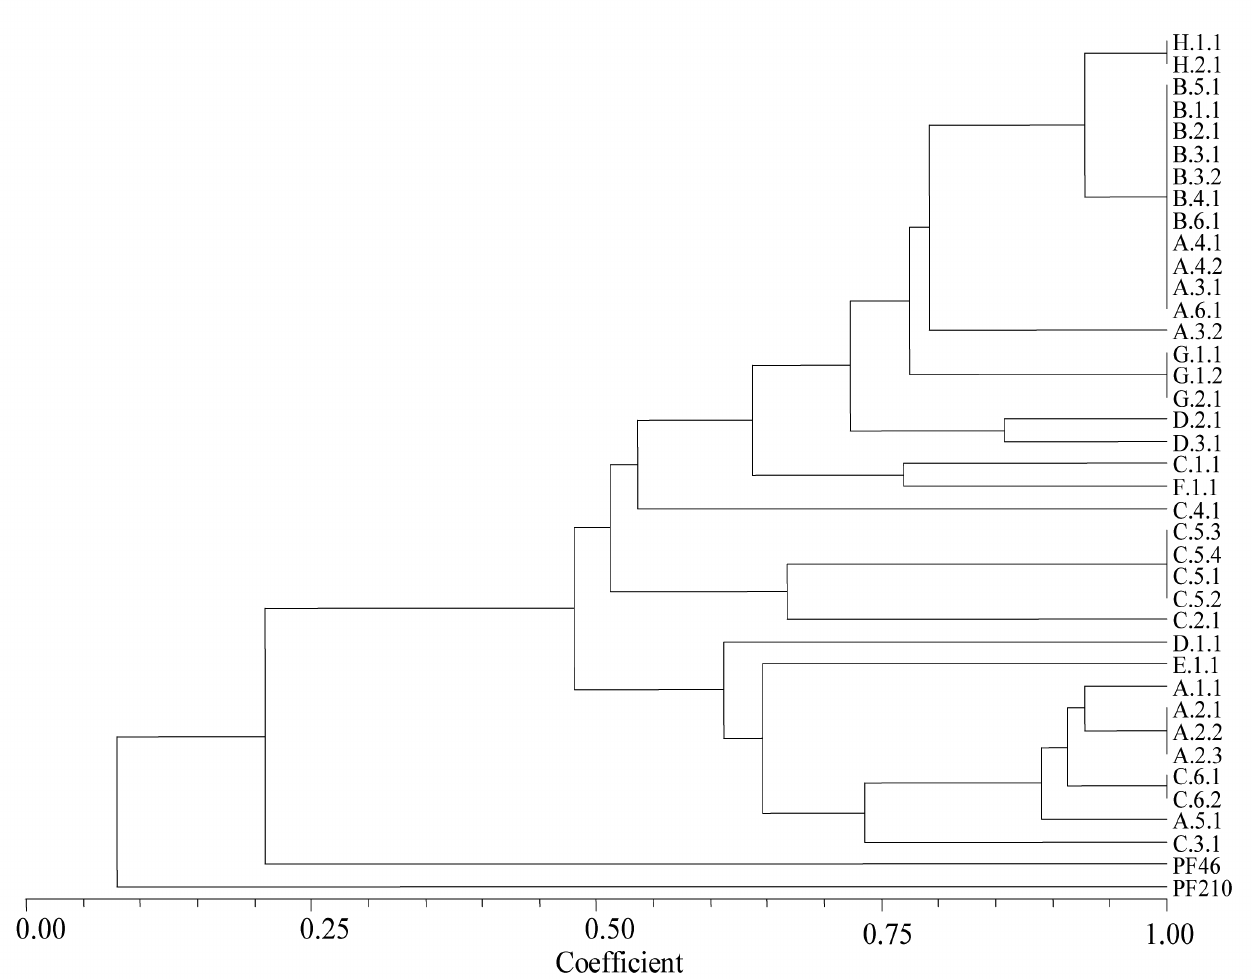
Figure 2. Dendrogram of RAMS and M13 profiles generated by UPGMA analysis, using Jaccard’s similarity coeffi- cient, from isolates of Inonotus rickii . Tested isolates are reported in Table 1. I. hispidus (PF 46) and Inocutis tama- ricis (PF 210) were used as